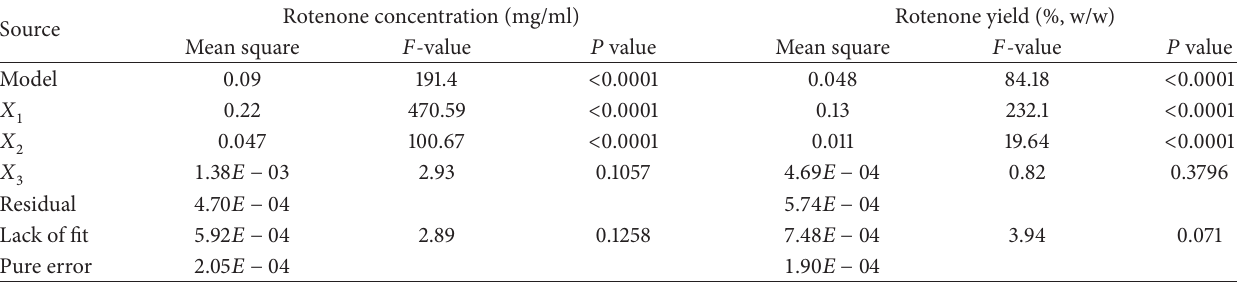
Table 3: Analysis of variance of the fitted linear equation for rotenone concentration and yield.